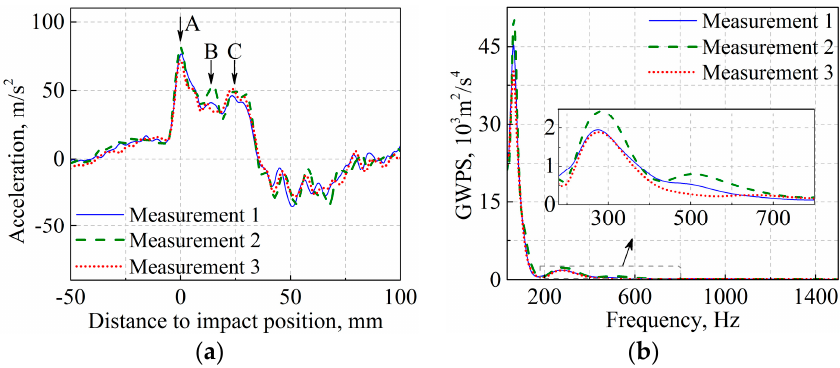
Figure 9. Measured ABA at the nominal crossing: ( a ) time history, and; ( b ) global wavelet power spectra (GWPS).